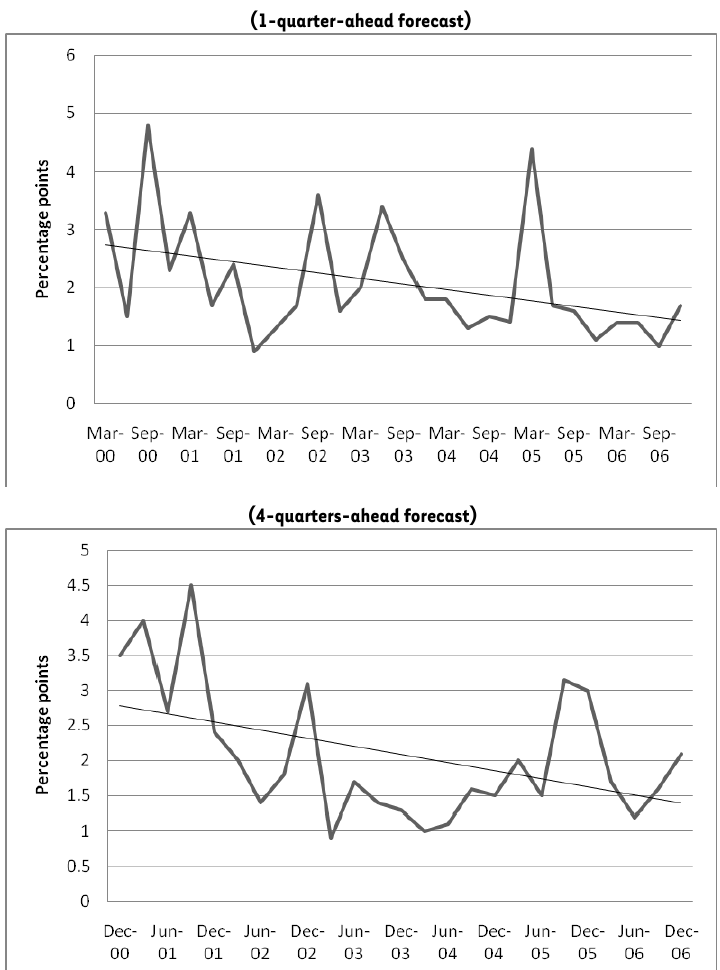
FIGURE 13: GDP forecast dispersion, 2000-2006